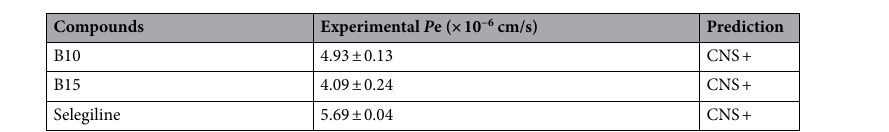
Table 2. Blood–Brain Barrier assay of key compounds of benzyloxy chalcones by PAMPA method. Pe (10 −6 cm/s) > 4.00: CNS + (high permeation); Pe (10 −6 cm/s) < 2.00: CNS − (low permeation ); Pe (10 −6 cm/s) from 2.00 to 4.00: CNS ± (BBB permeation